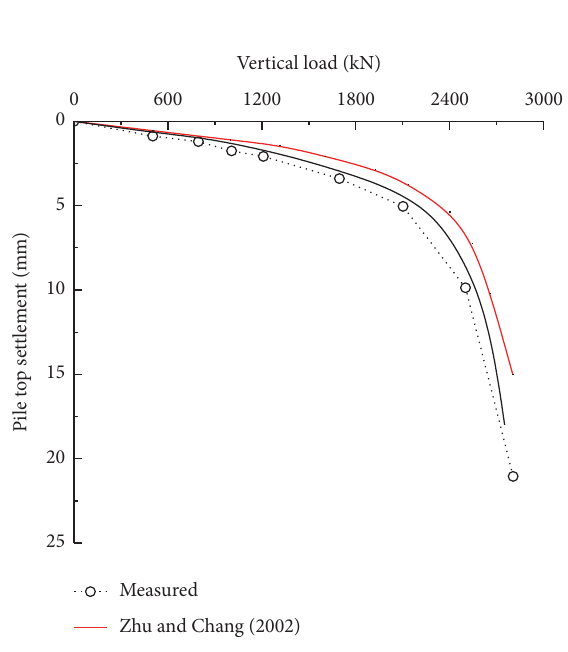
Figure 4: Pile and soil system.